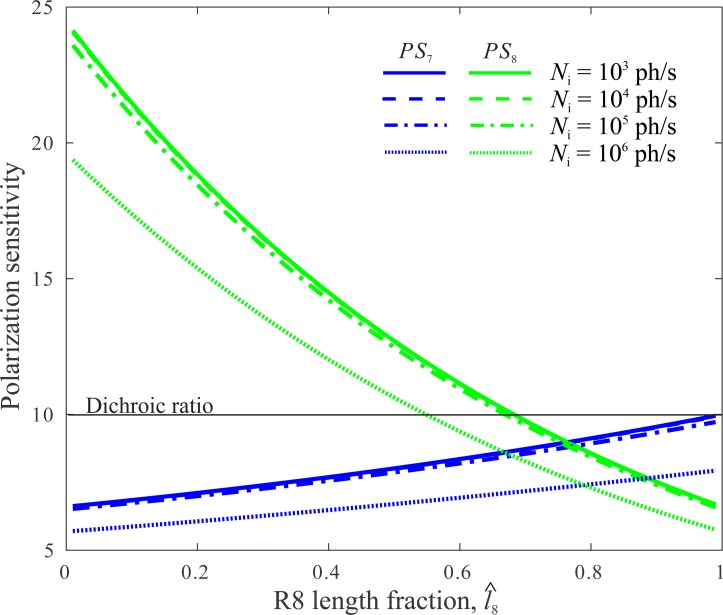
Polarization sensitivities of R7 and R8, PS7 and PS8, depend on division of CRP between R7 and R8, as specified by R8’s length fraction \documentclass[12pt]{minimal}
\usepackage{amsmath}
\usepackage{wasysym}
\usepackage{amsfonts}
\usepackage{amssymb}
\usepackage{amsbsy}
\usepackage{upgreek}
\usepackage{mathrsfs}
\setlength{\oddsidemargin}{-69pt}
\begin{document}
}{}$\hat {{l}_{8}}$\end{document}l8 ˆ.PS7 and PS8 do not vary with light level below Ni = 104 photons s−1. Above this incident photon flux, saturation reduces PS.